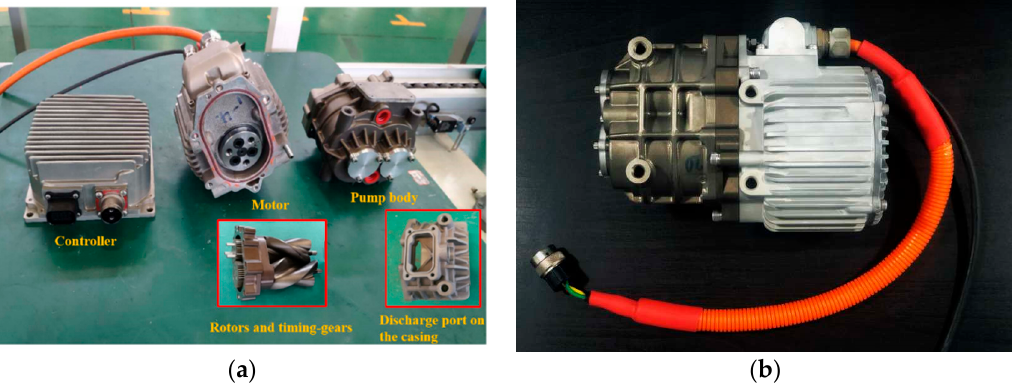
Figure 3. Prototype of the Roots pump: ( a ) components of the pump body, motor, and controller; and ( b ) assembly of the pump body and motor.